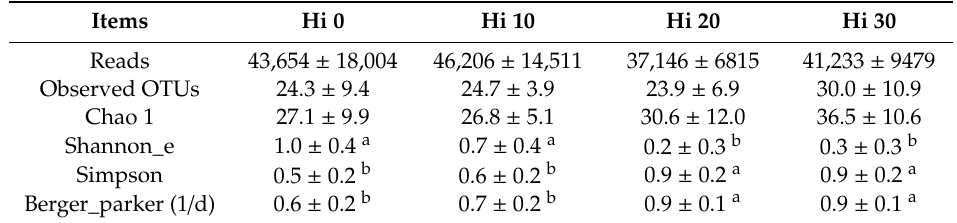
Table 2. Number of reads per sample assigned to OTUs and alpha diversity metrics values (normalized at the lowest sample size: 17,800 sequences) of gut microbial community of rainbow trout fed Hi 0 ( n = 9), Hi 10 ( n = 9), Hi 20 ( n = 9), and Hi 30 ( n = 9) diets for 12 weeks.